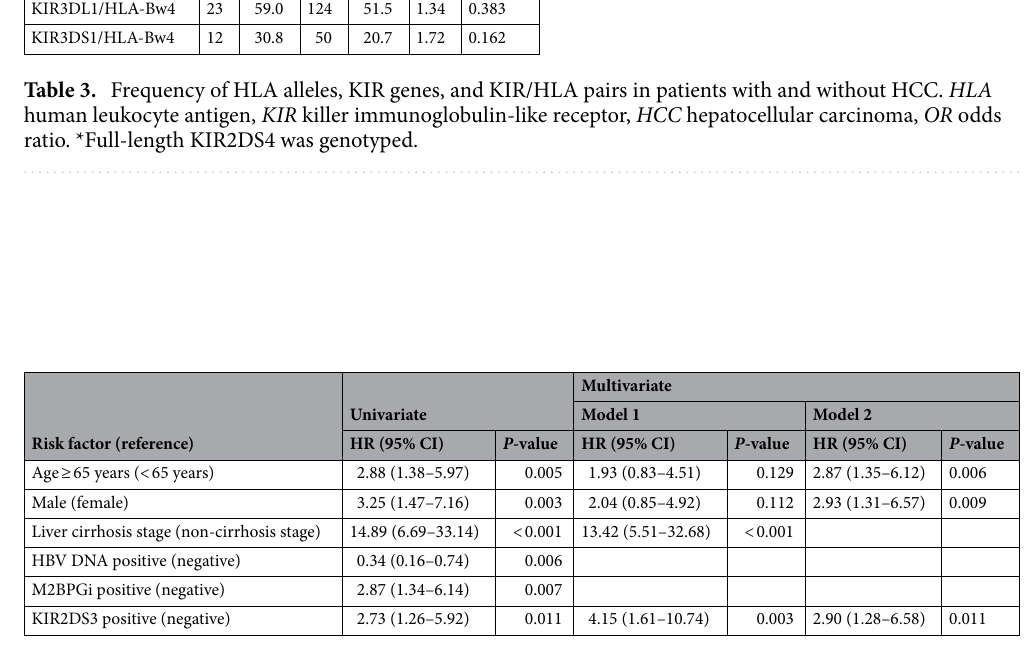
Table 4. Independent risk factors of HCC development in HBV patients by logistic regression analysis. Model 1 included all risk factors in calculations. Model 2 included age, gender, and KIR2DS3 in calculations.